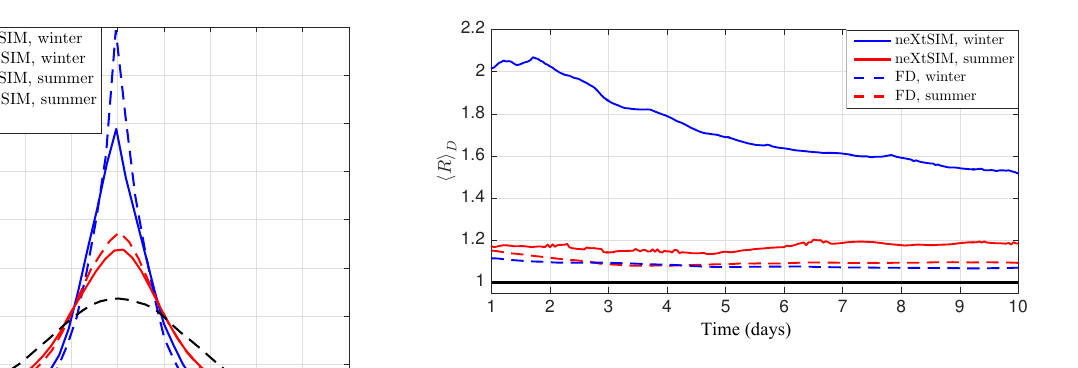
Figure 11. Evolution of the spatial mean of R(t) from t = 1 to t = 10 days for the winter (blue) and summer (red) periods for neXtSIM (solid lines) and FD (dashed